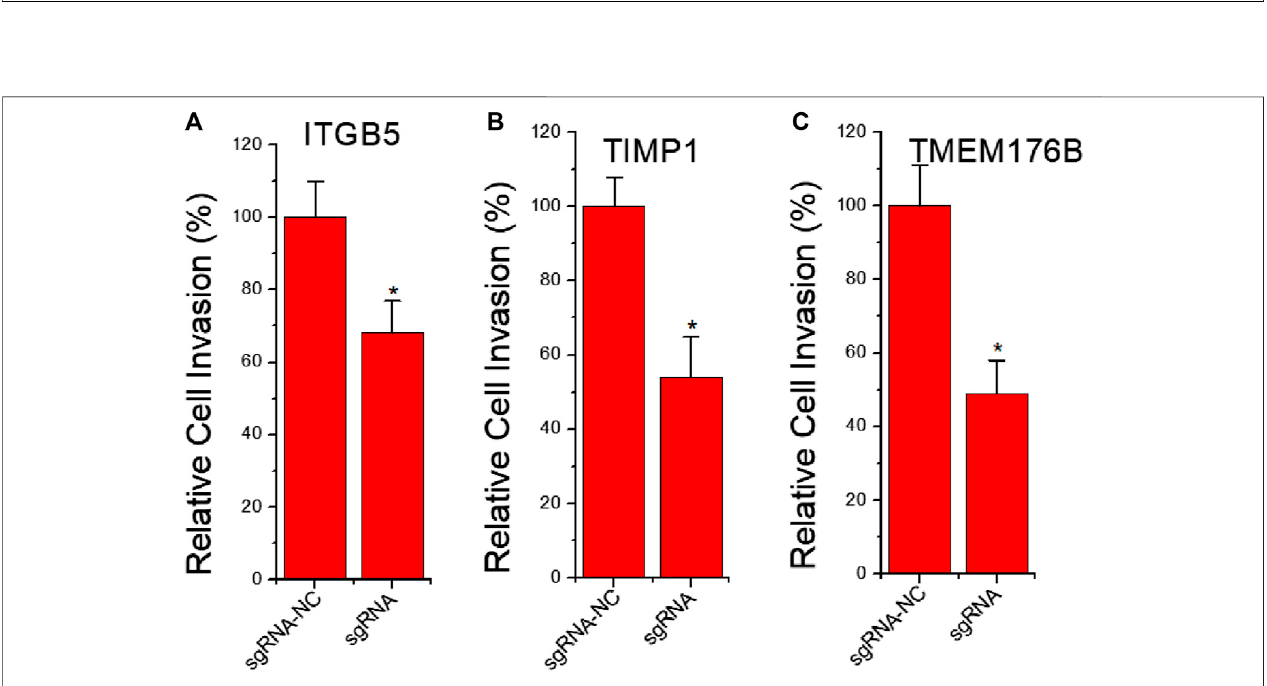
FIGURE 4 | The effects of knockdown of ITGB5 or activation of TIMP1 and TMEM176B expression on cell invasion. LNCap cells were transfected by CRISPRi or CRISPRa systems and cell migration assay revealed that knockdown of ITGB5 (A) or activation of TIMP1 (B) and TMEM176B (C) expression inhibited the invasion rate of LNCap cells.